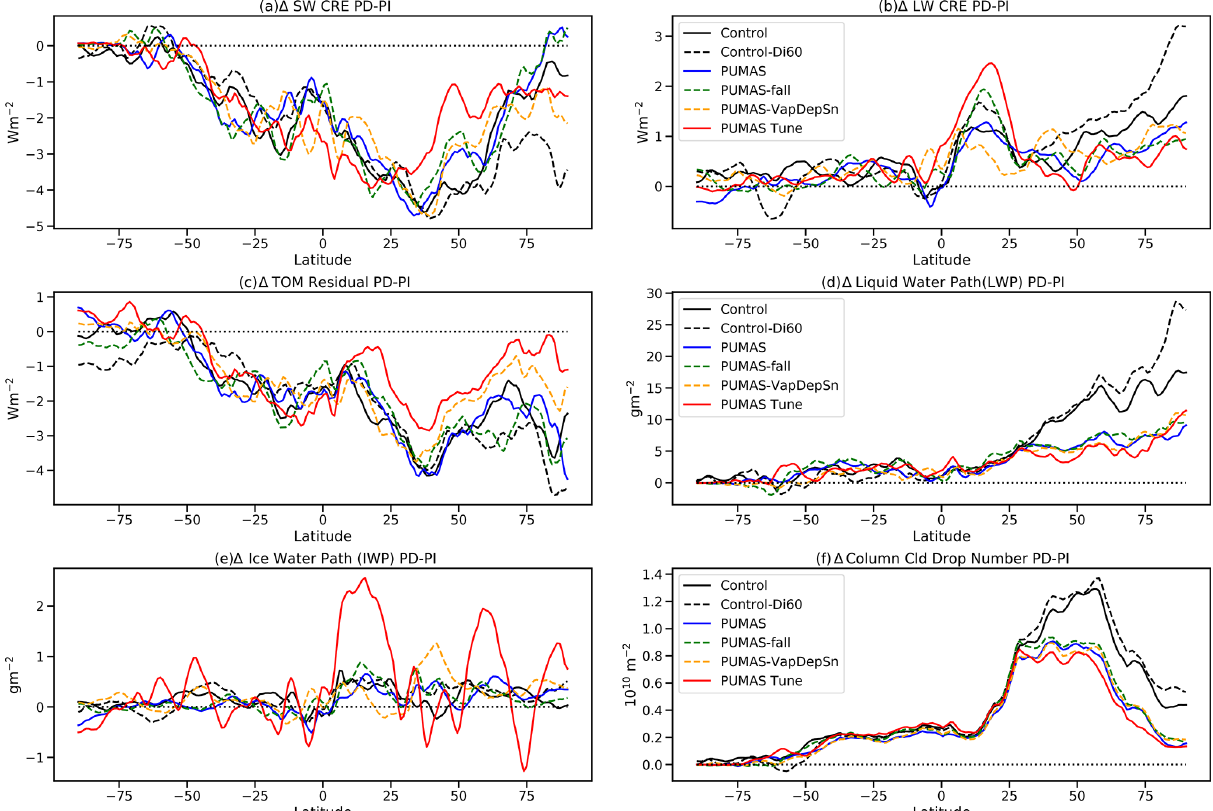
Figure 9. Zonal mean differences between control (PD) and 1850 aerosol (PI) simulations for four pairs of runs, i.e., control (black), Control- Di60 (black dash), PUMAS (blue), PUMAS-Fall (green dash), PUMAS-VapDepSn (orange dash), and PUMAS-Tune (red). Simulation names are defined in Table 1. Results are shown for the (a) change in SW CRE, (b) change in LW CRE, (c) change in net top-of-model flux (RESTOM), (d) change in LWP, (e) change in IWP, and (f) change in the column drop